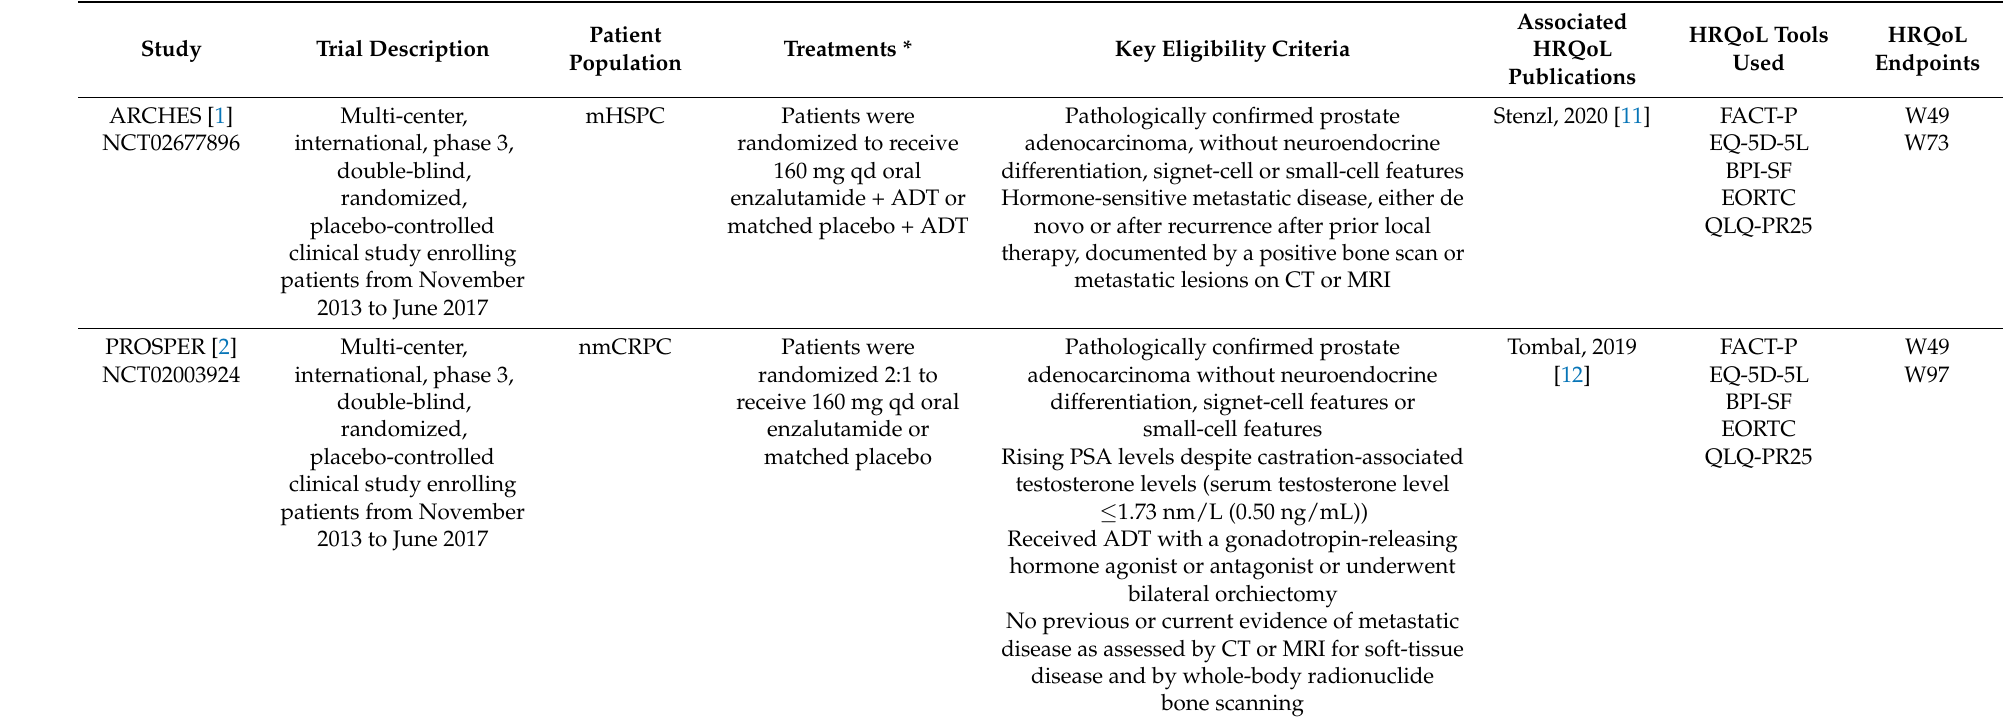
Table 1. Overview of key enzalutamide